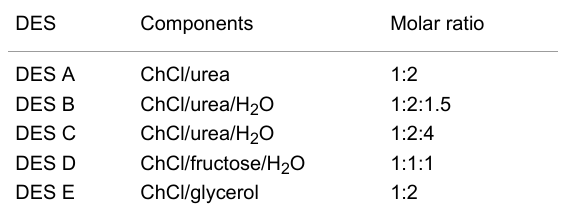
Table 1: ChCl-based eutectic mixtures used in the present work. DES